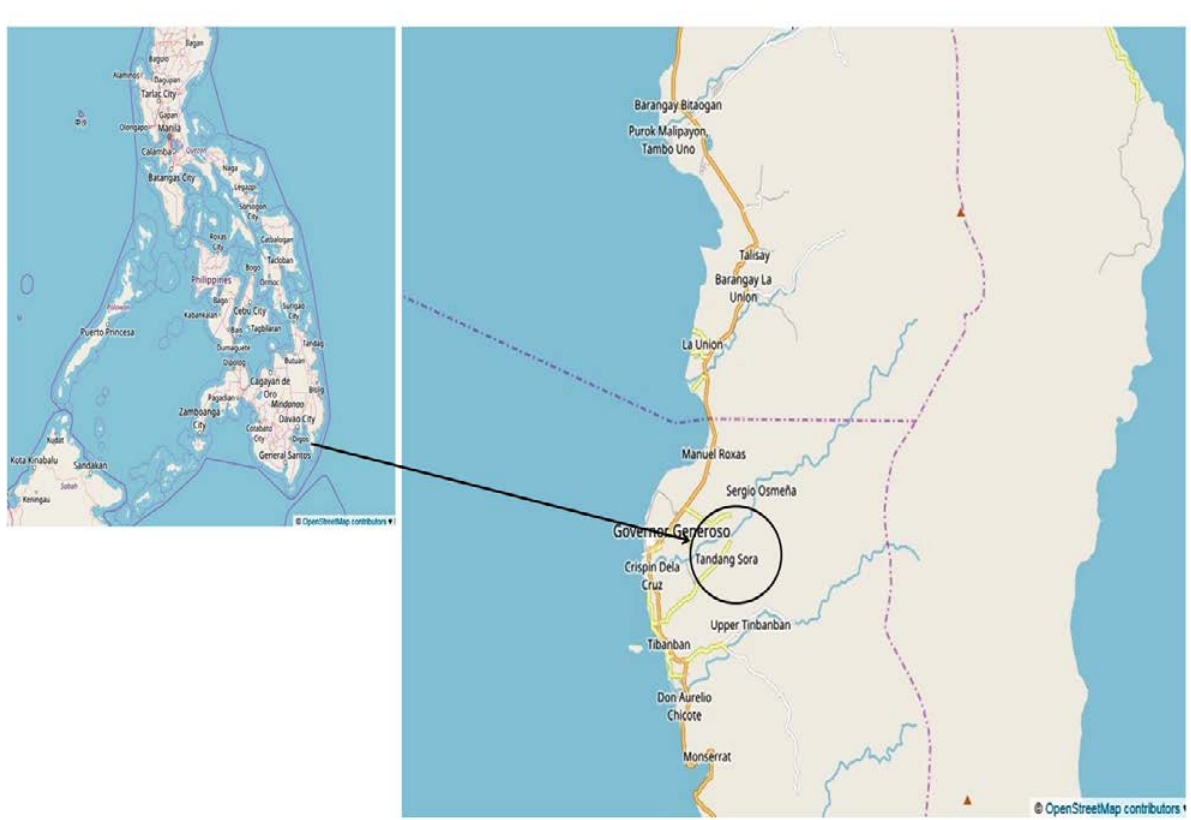
Fig. 3 A. Map of the Philippines; B. Map of Mt. Hamiguitan Range Wildlife Sanctuary showing the location of R. antoniae [Map copyright by © OpenStreetMap